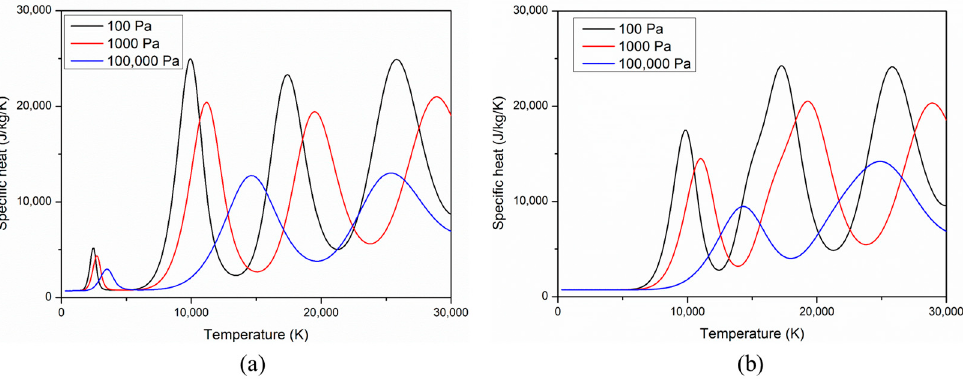
Figure 2. Variation of gas specific heat with temperature at different pressures: ( a ) Ar-17% vol. H 2 , and ( b ) Ar-34% vol. He.